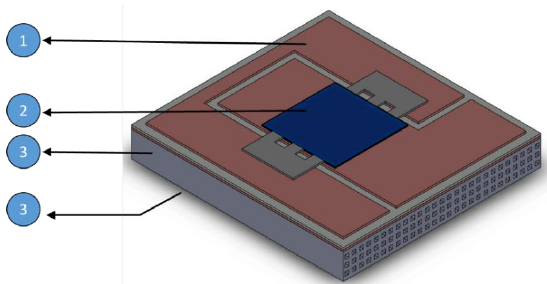
Figure 6. Schematic of the computational domain and boundary conditions: 1 (cid:13) copper layer surface; 2 (cid:13) ERH; 3 (cid:13) top and bottom multi-layered outer